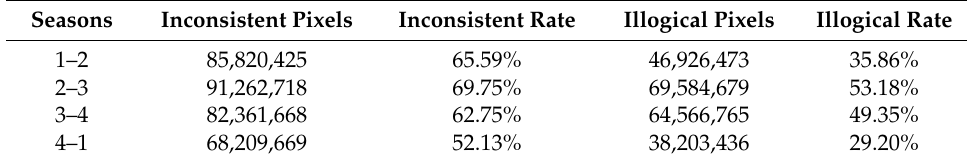
Table 7. Inconsistent pixel statistics by the initial maps.